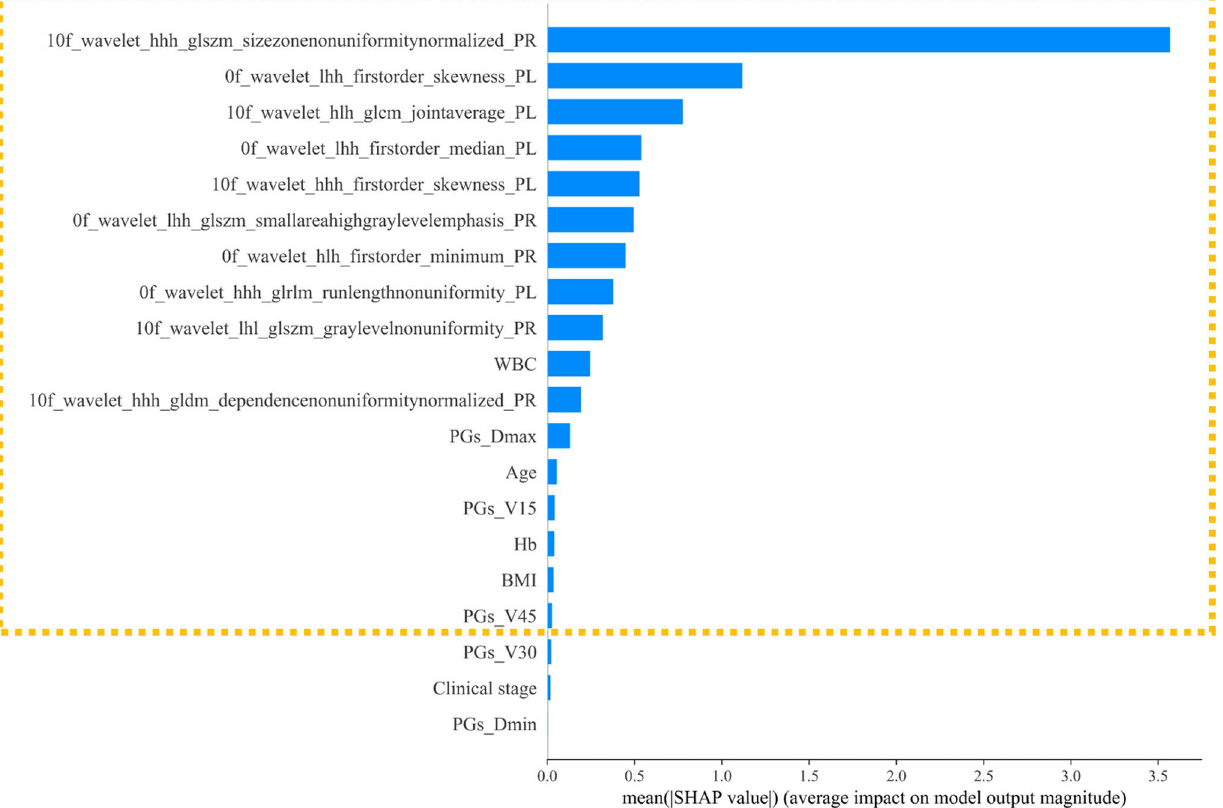
Fig. 3 SHAP analysis of integrated